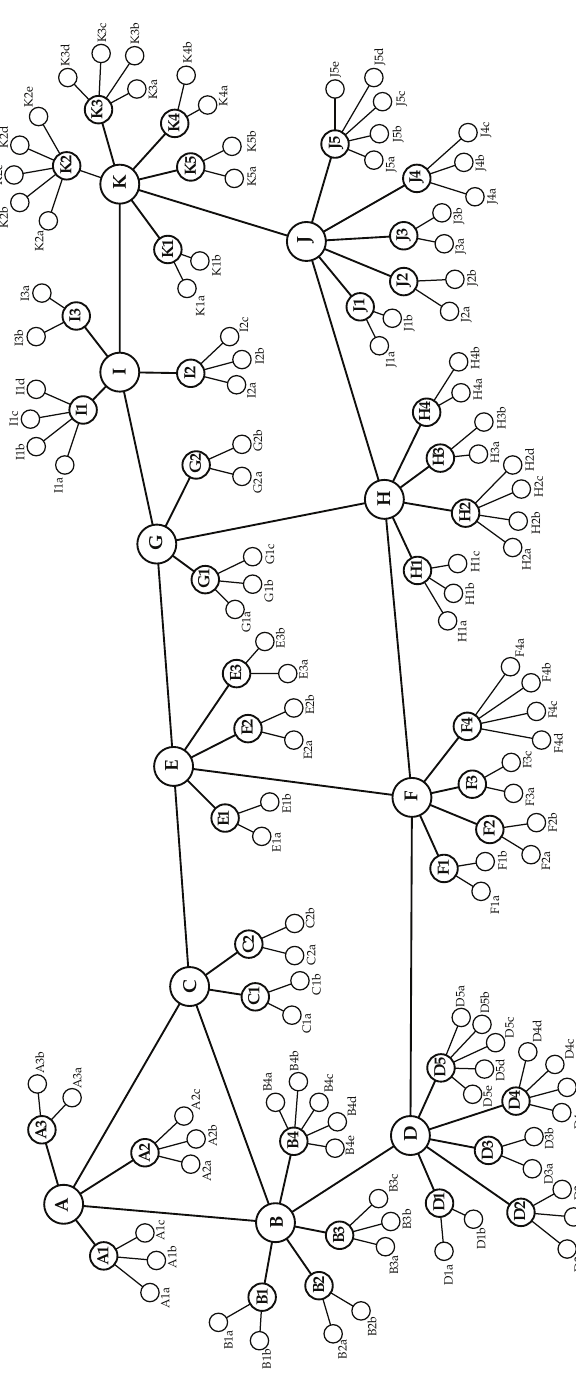
Figure 1: The simulation model with 11 backbone routers, 40 subnet routers, 110 leaf routers, and 22000